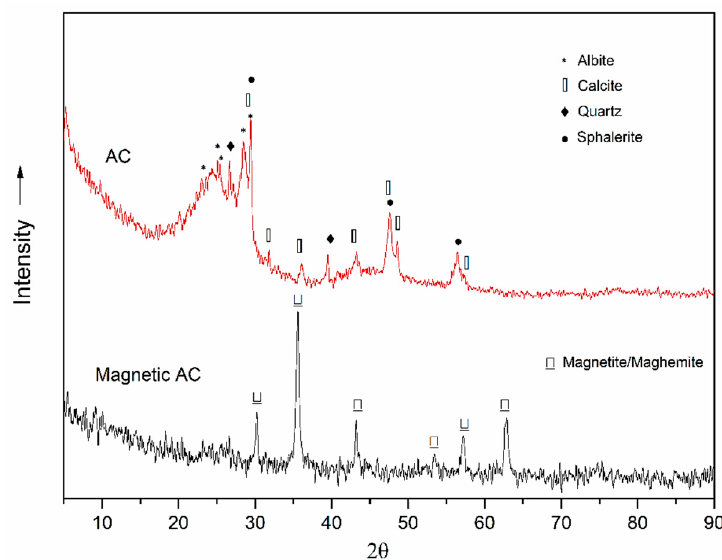
Figure 2. XRD patterns of tire waste-derived AC and